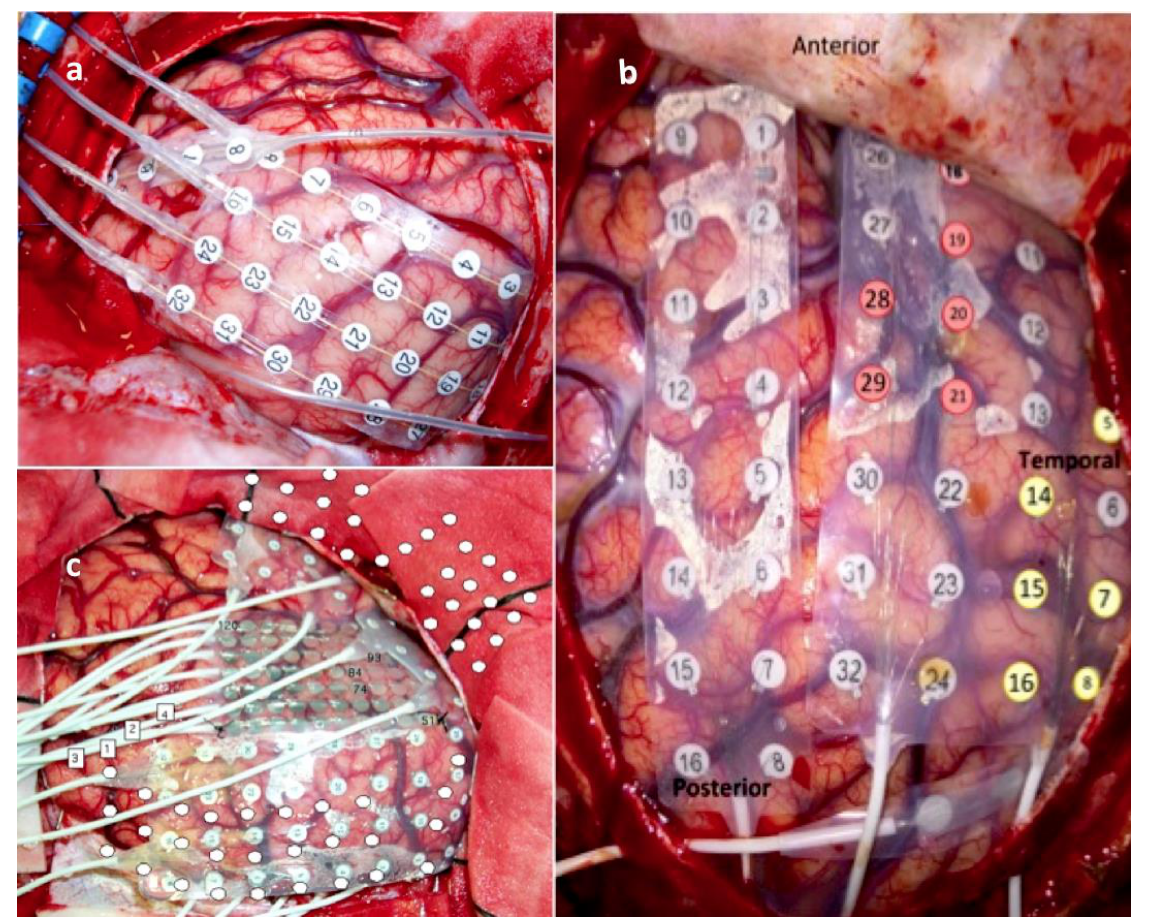
Figure 1. ( a – c ) Intraoperative photos (during the implantation procedure) demonstrate various combinations of strip and grid subdural electrodes for extra-operative stimulation and mapping. Adequate cortical exposure is required for safer electrode implantation.